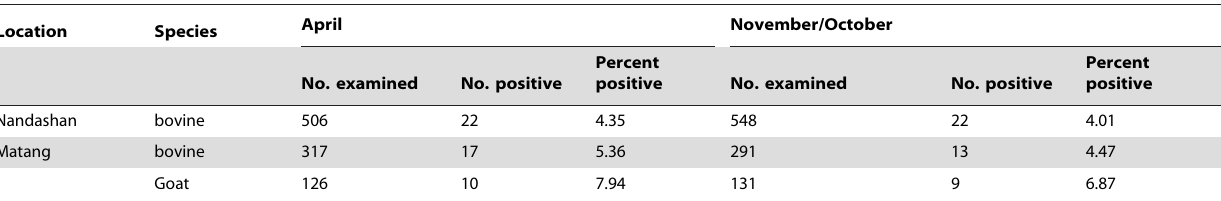
Table 5. Positive rates in field